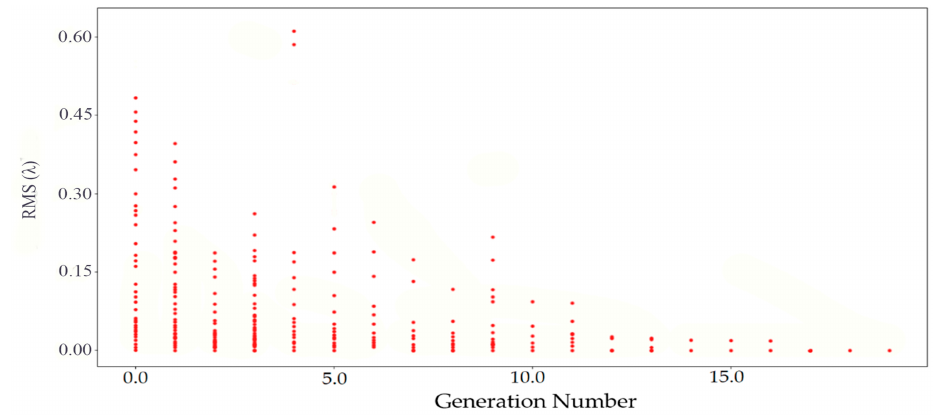
Figure 6. The search process of the strategy unit.